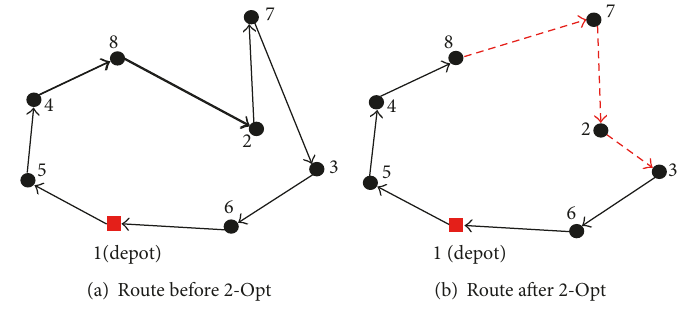
Figure 7: The demo of 2-Opt